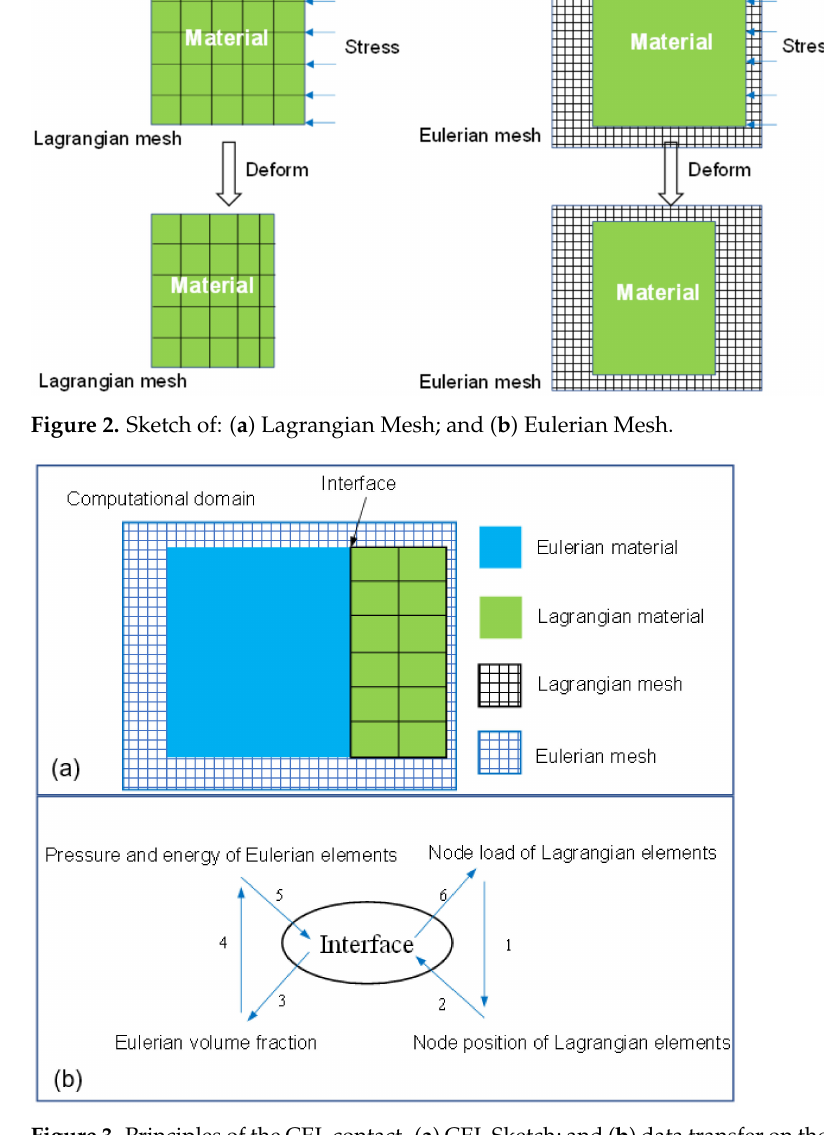
Figure 3. Principles of the CEL contact. ( a ) CEL Sketch; and ( b ) data transfer on the coupling